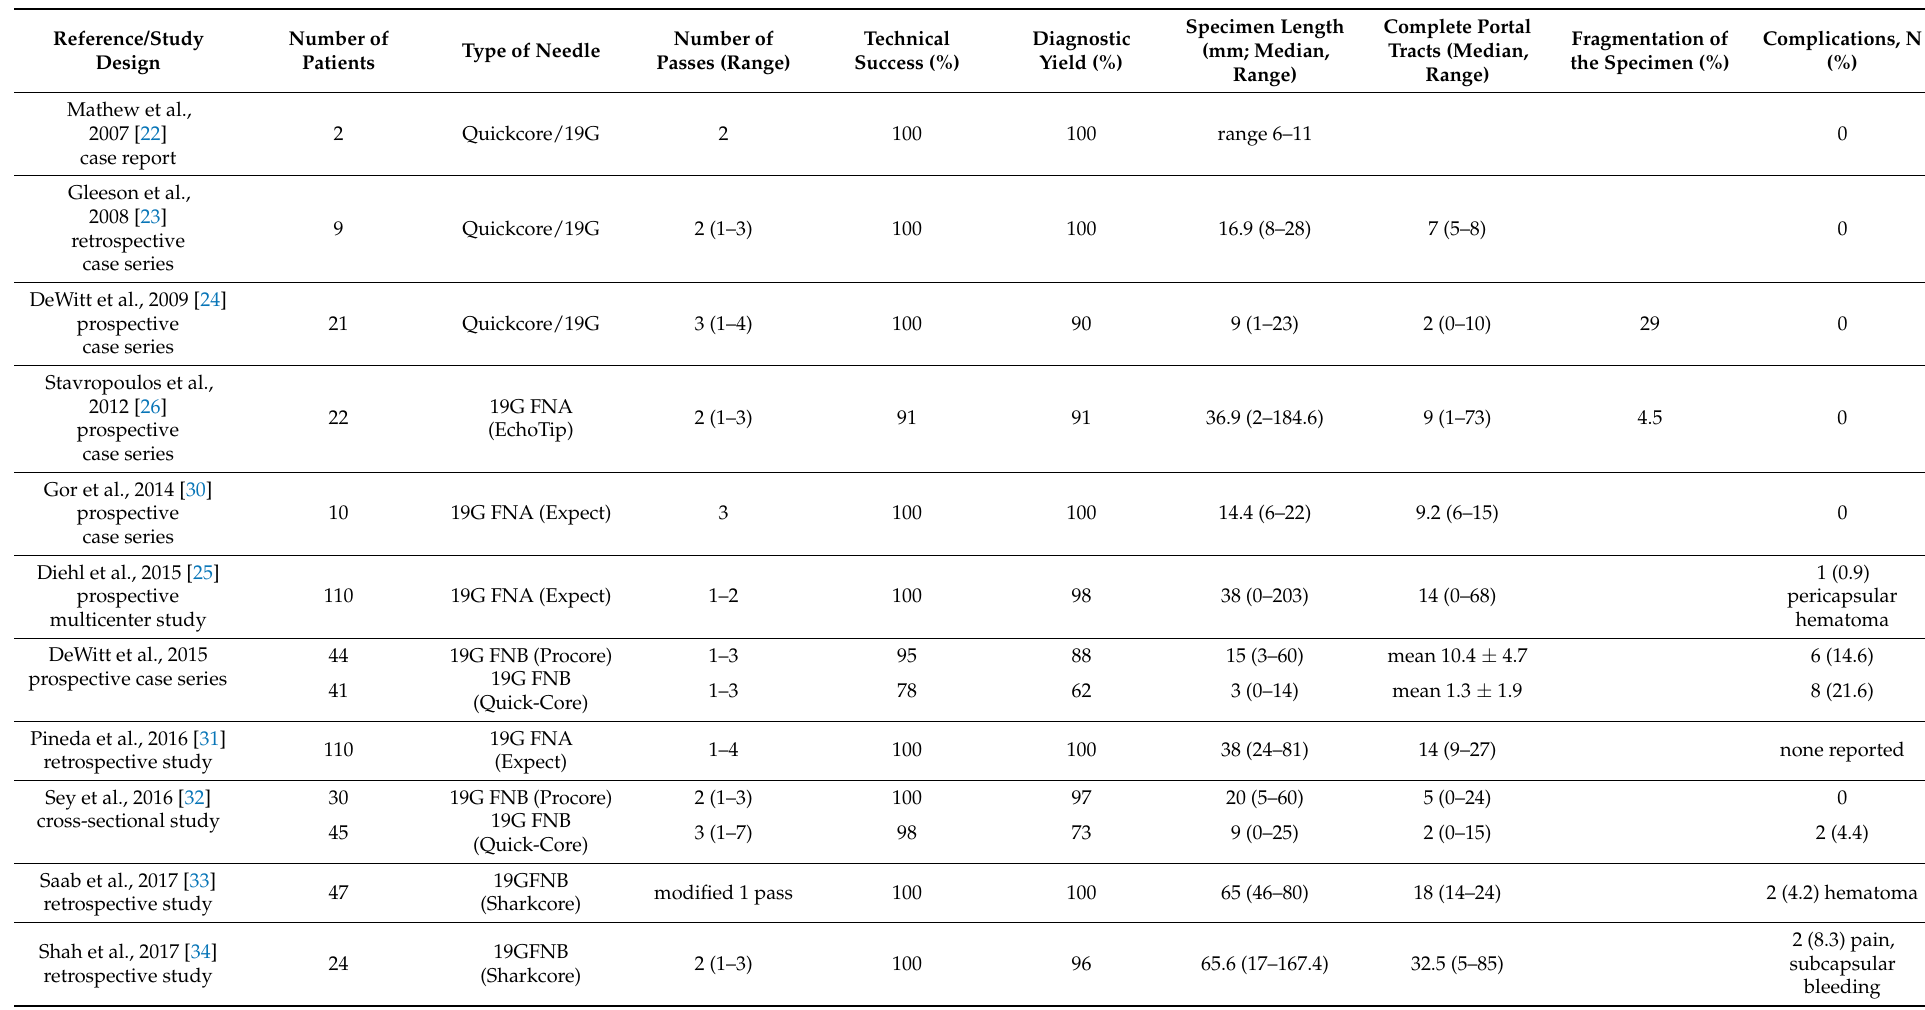
Table 1. Summary of studies evaluating the diagnostic yield, accuracy, and safety profile of EUS guided liver biopsy for parenchymal liver